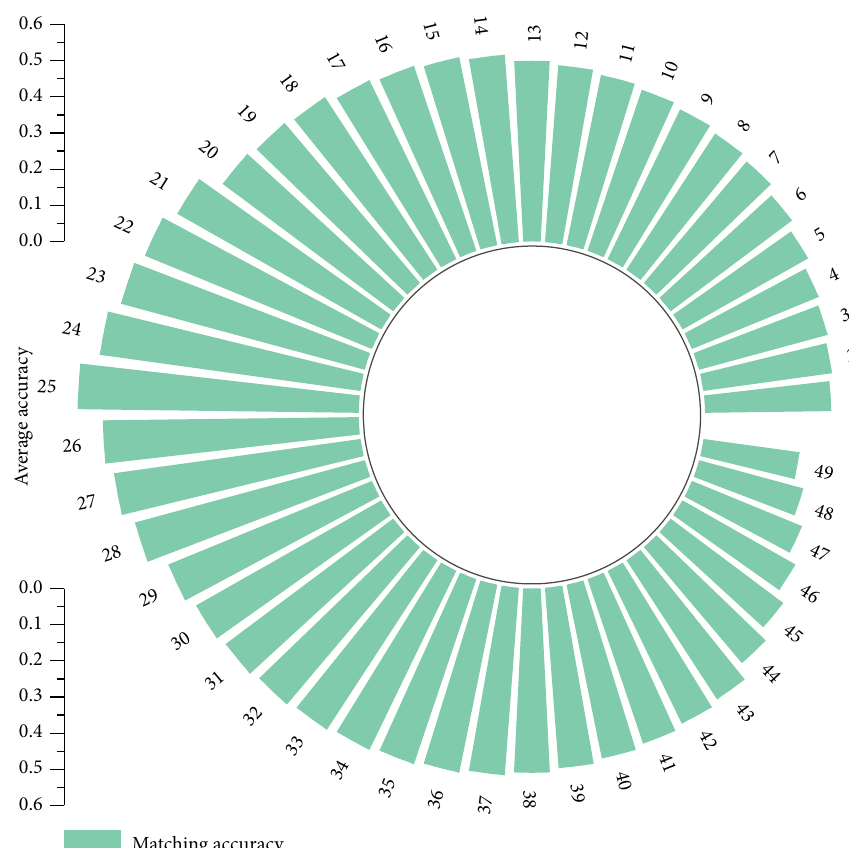
Figure 6: Statistical chart of accuracy of audio space feature vector analysis.